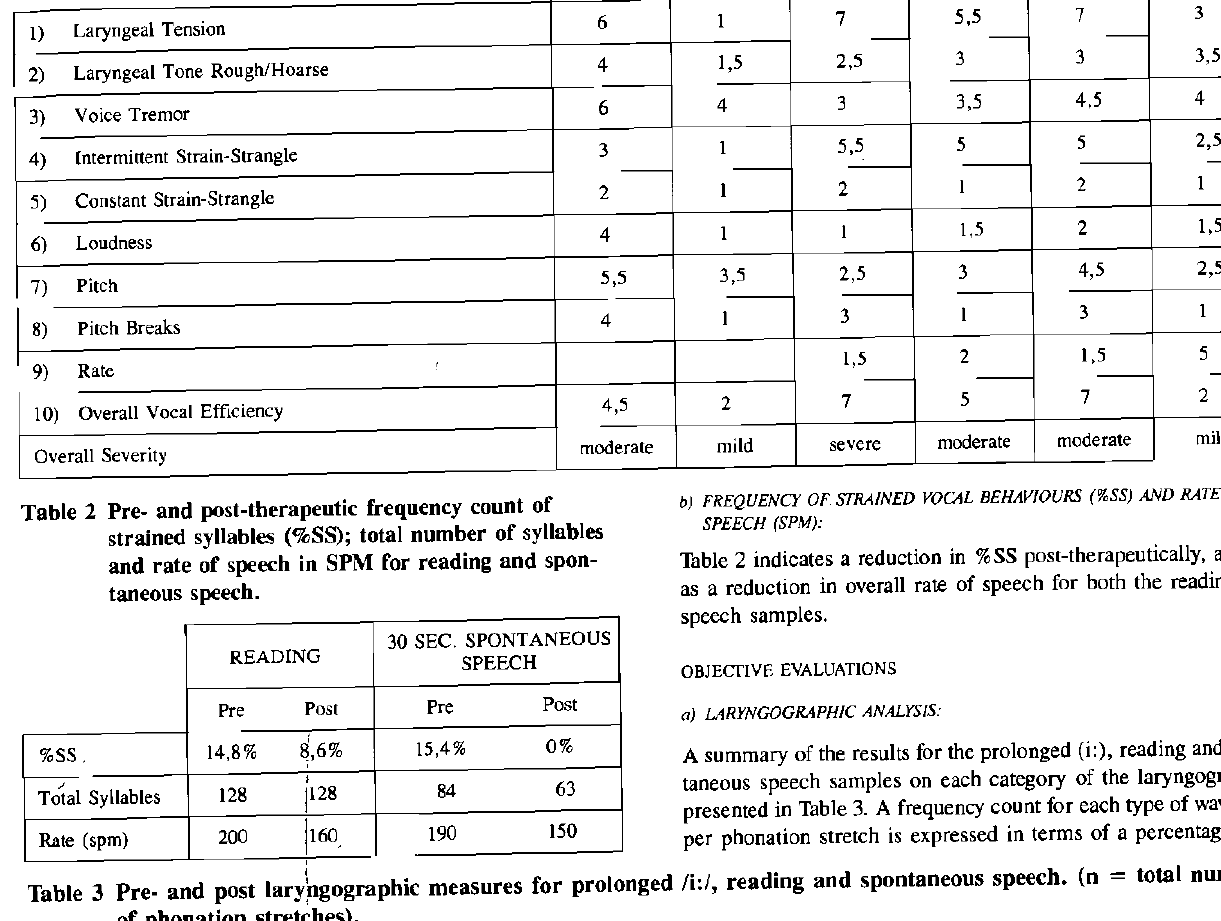
Vocal Parameter